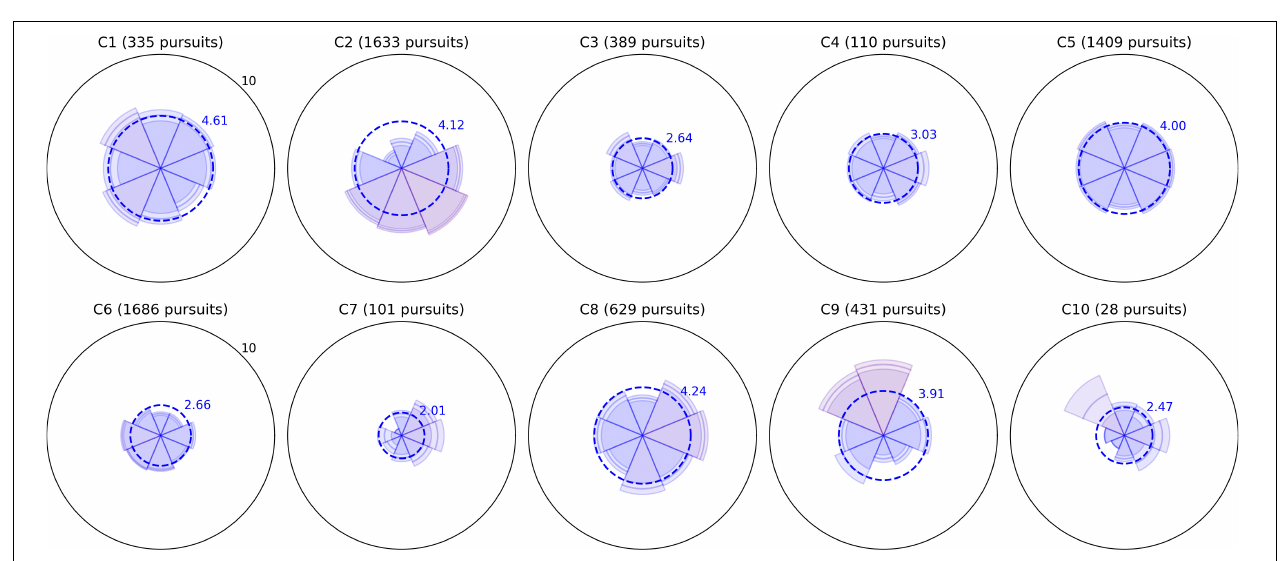
FIGURE 4 | Radial histograms of pursuit frequency and mean bias vectors in Moving Bubbles. Pursuits in the Moving Bubbles task were binned into eight directions. The upper radial axis limit of each plot is a proportional score of 0.5. As in previous figures, the sector bins gradually change in color from blue to red as the proportion for that bin exceeds the mean of 0.125. The participant number and total pursuit count are given above each plot. The arrow originating from the center of each plot represents the Cartesian mean of all pursuits’ unit direction vectors, and thus indicates the direction and strength of an overall bias in pursuit direction. The five plots with gray backgrounds exhibit a particularly strong directional bias and have corresponding radial histograms from Field Bubbles shown in Figure 6 .